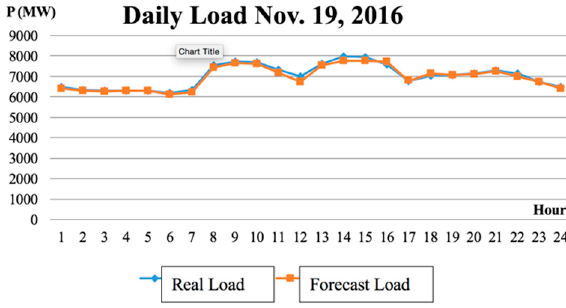
Figure 10. The result of 19 November 2016.